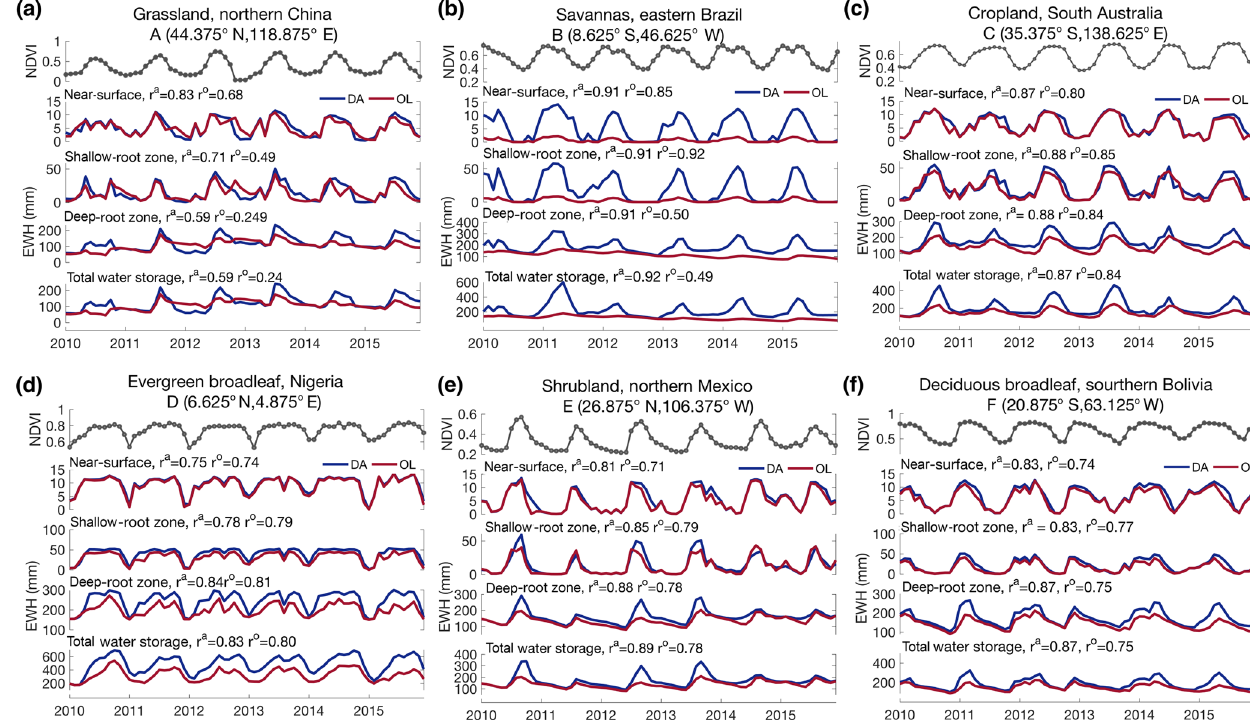
Figure 5. Time series of vegetation responses (NDVI) to soil water storage over different integrated depths across land vegetation types before ( r o , red curves) and after the joint assimilation ( r a , blue curves). The location of each site is shown in Fig. 1.